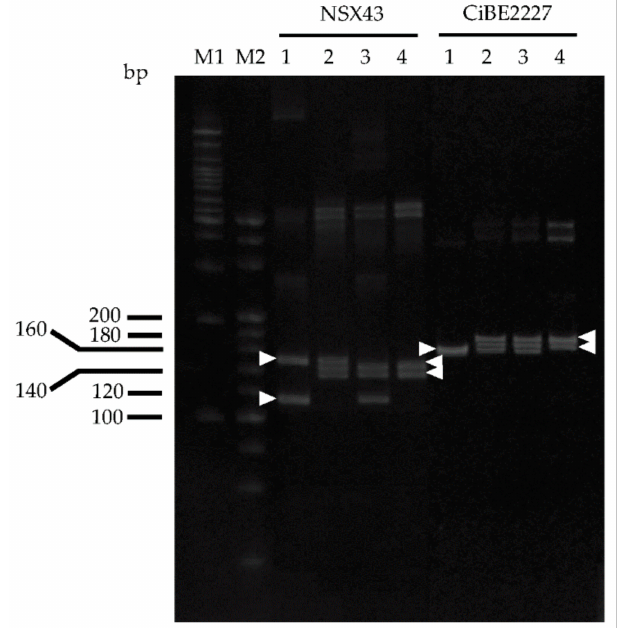
Figure 2. SSR analysis of ‘Kiyomi’ tongor, Meiwa kumquat, and their hybrids with PAGE in NSX43 (LG5) and CiBE2227 (LG8) loci. Arrowheads indicate the bands specific to each parent. M1: 100 bp lad- der marker, M2: 20 bp ladder marker, 1: ‘Kiyomi’ tongor, 2: H15-701, 3: H15-702, 4: Meiwa kumquat.